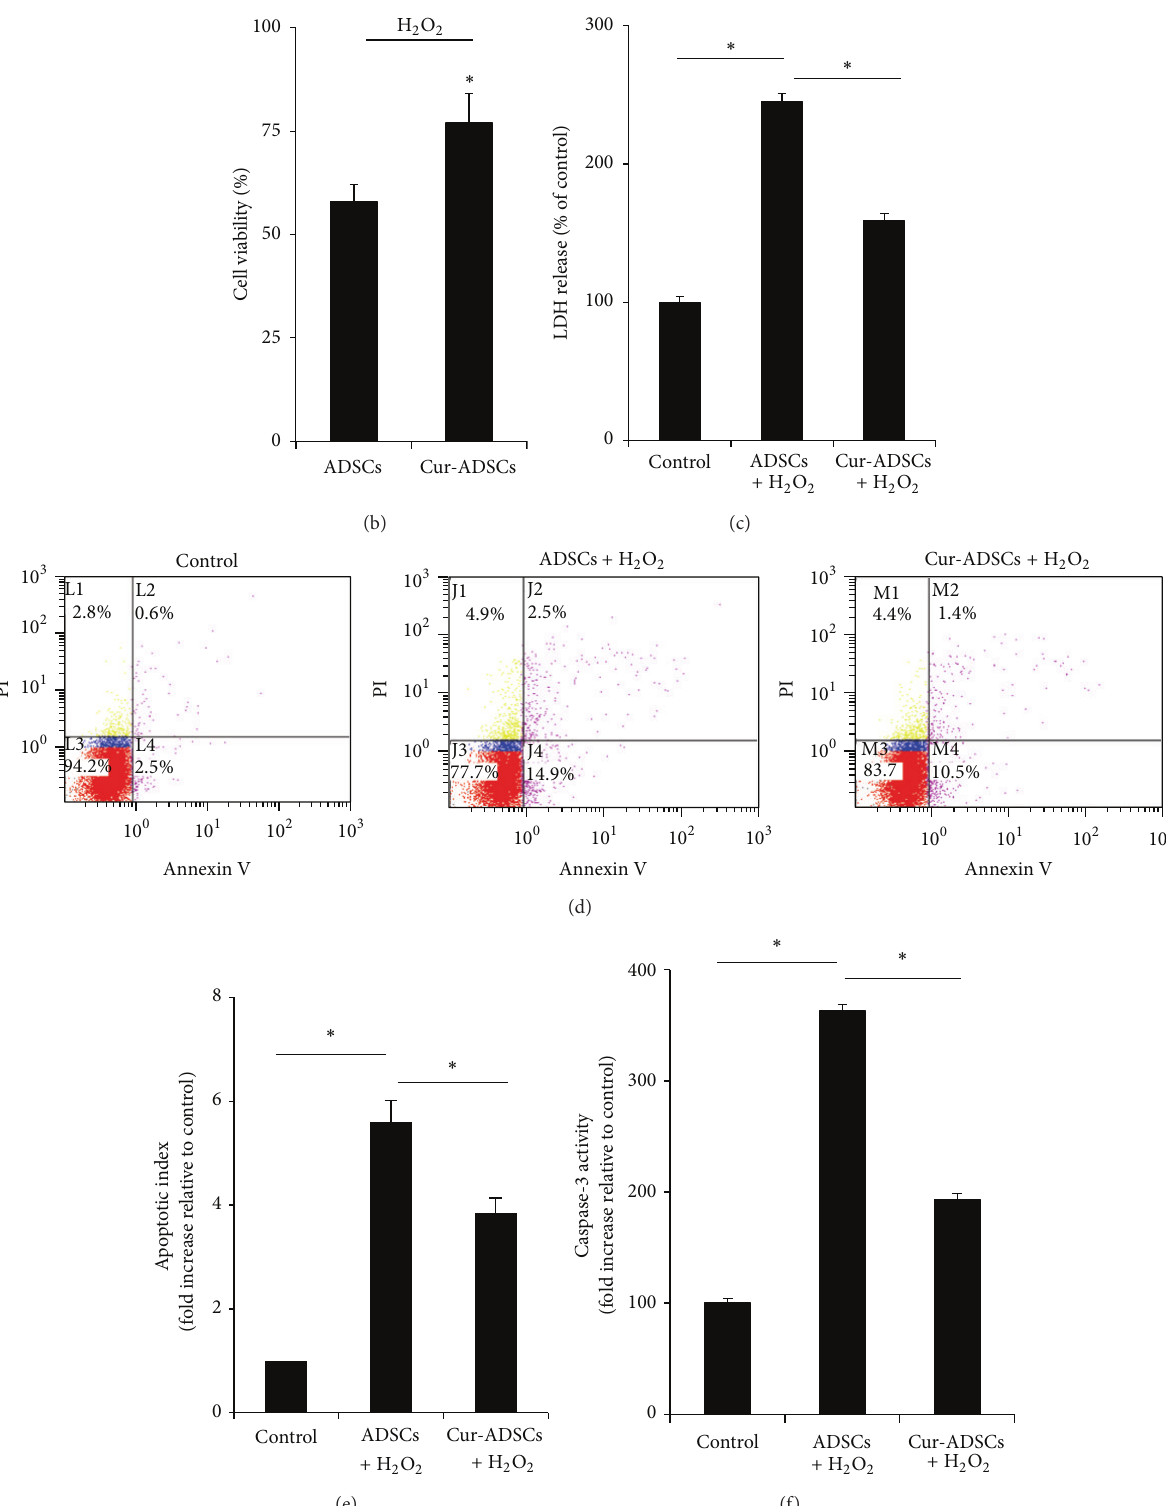
Figure 1: Immunophenotype characterization of ADSCs and cytoprotective effects of curcumin pretreatment on ADSCs. (a) Expressions of cell phenotypes. CD90 and CD105 are positive. CD31, CD34, and CD45 are negative. (b) Trypan blue exclusion analysis showed cell viability was improved by curcumin pretreatment. (c) Quantitative analysis of LDH production in the cell supernatant revealed curcumin pretreatment reduced cells injury. ((d) and (e)) Representative Annexin V/PI staining showed curcumin pretreatment prevented apoptosis of ADSCs ( 𝑃 < 0.05 ). (f) Curcumin pretreatment protected ADSCs against H 2 O 2 /SD induced caspase-3 activation ( 𝑃 < 0.05 ). ∗ 𝑃 < 0.05